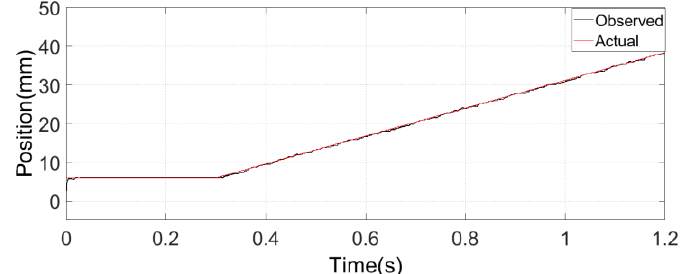
Figure 9. Frequency spectrum comparison of ˆ q